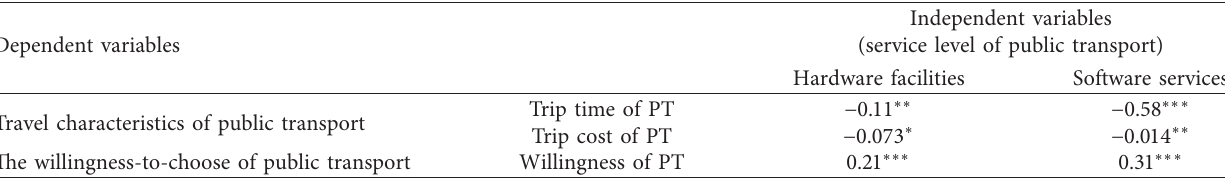
Table 8: Effect of the service level of public transport on the endogenous variables.